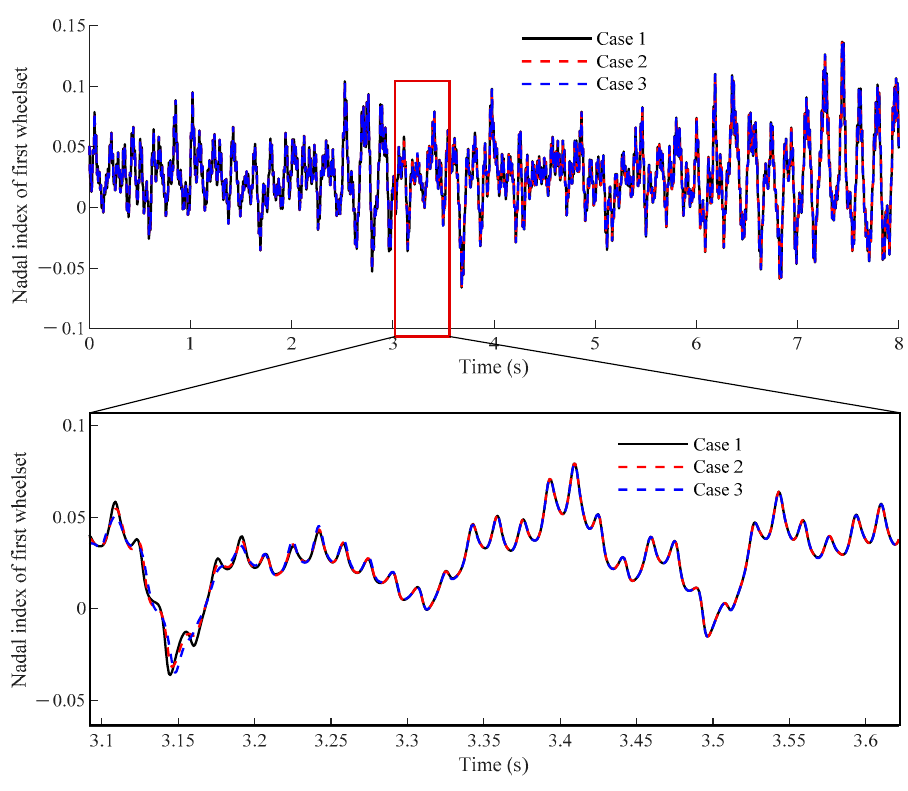
Figure 5. Time–history curve of the Nadal index.